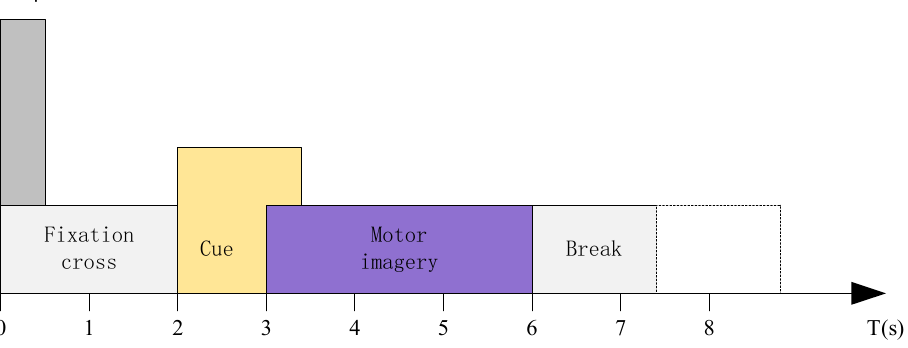
Figure 10. Experimental paradigm timing diagram.